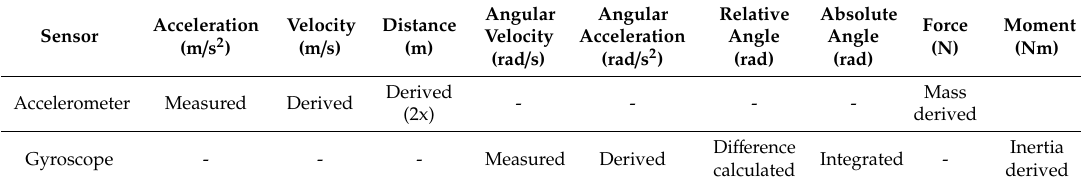
Table 4. How accelerometers and gyroscopes work in computing desired sport physical attributes. Sensor